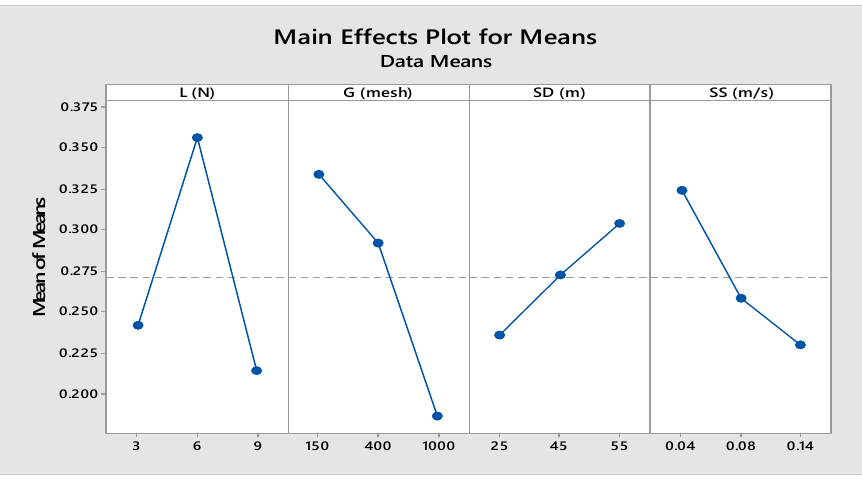
Figure 10. Main effect plot for mean T s of PTFE matrix composites. 3.3. Single Response Optimization and ANOVA The computed SNRs response table for M L , V L , μ , and T s are shown in Tables 4–7, respectively. The maximum value of SNRs at the main effect plot for SNRs gave the de ‐ sired results. Bolded values in the response tables for SNRs show the desired SNRs. Based on Table 4 and Figure 11, the optimum process variables for obtaining low M L using the Taguchi technique were found to be L = 3 N, G = 1000 mesh, SD = 25 m, and SS = 0.04 ms − 1 . The corresponding level values are presented in bold to facilitate understand ‐ ing of the mean SNRs response table. This predicted combination of optimum parameters for M L was coded as L1G1SD1SS1. According to Table 5 and Figure 12, the estimated op ‐ timum settings for achieving minimum V L was determined to be L = 3 N, G = 1000 mesh, SD = 55 m, and SS = 0.04 ms − 1 . This combination of optimum settings is coded as L1G3SD3SS1. From Figure 13 and Table 6, it was observed that the maximum mean SNRs achieved for μ were L at 9 N, G at 1000 mesh, and SD at 25 m, and SS at 0.14 ms − 1 . Thus, the estimated optimum process parameter settings for achieving a minimum μ via the Taguchi method can be coded as L3G1SD1SS3. As seen in Figure 14 and Table 7, the high ‐ est mean SNRs obtained for T s were L at 9 N, G at 1000 mesh, and SD at 55 m, and SS at 0.04 ms − 1 . Therefore, using the Taguchi method, the predicted optimum parameter set ‐ tings are styled as L3G1SD3SS1.